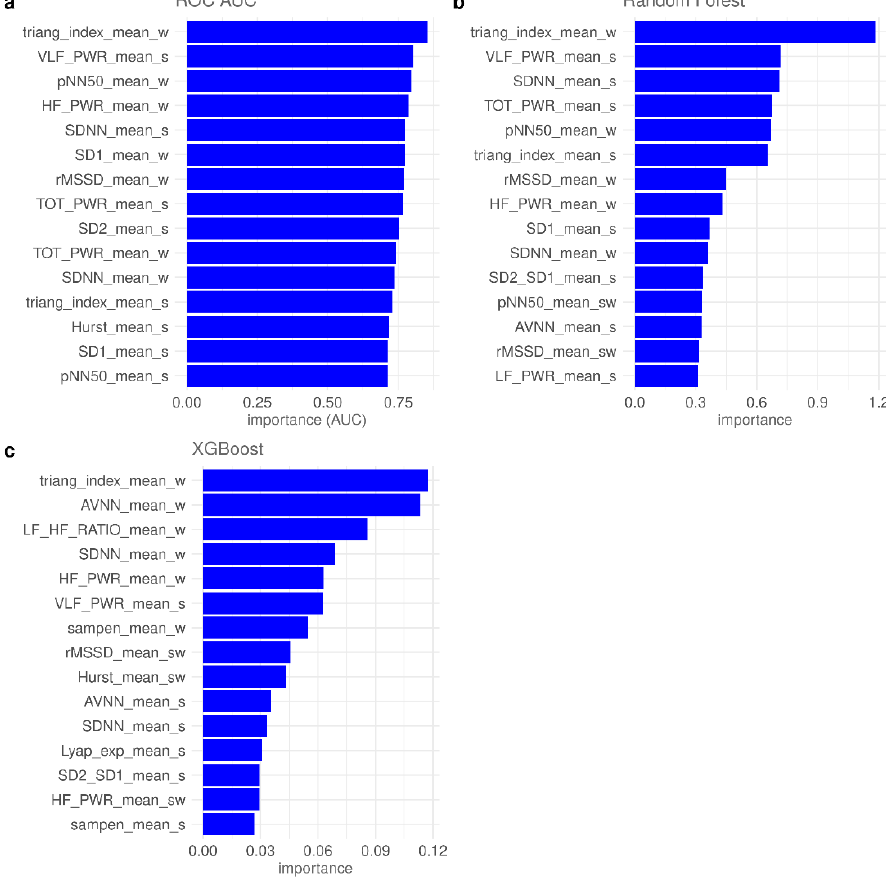
Figure 2. Feature importances evaluated from ( a ) ROC AUC and other ML models: ( b ) Random Forest and ( c ) XGBoost models.